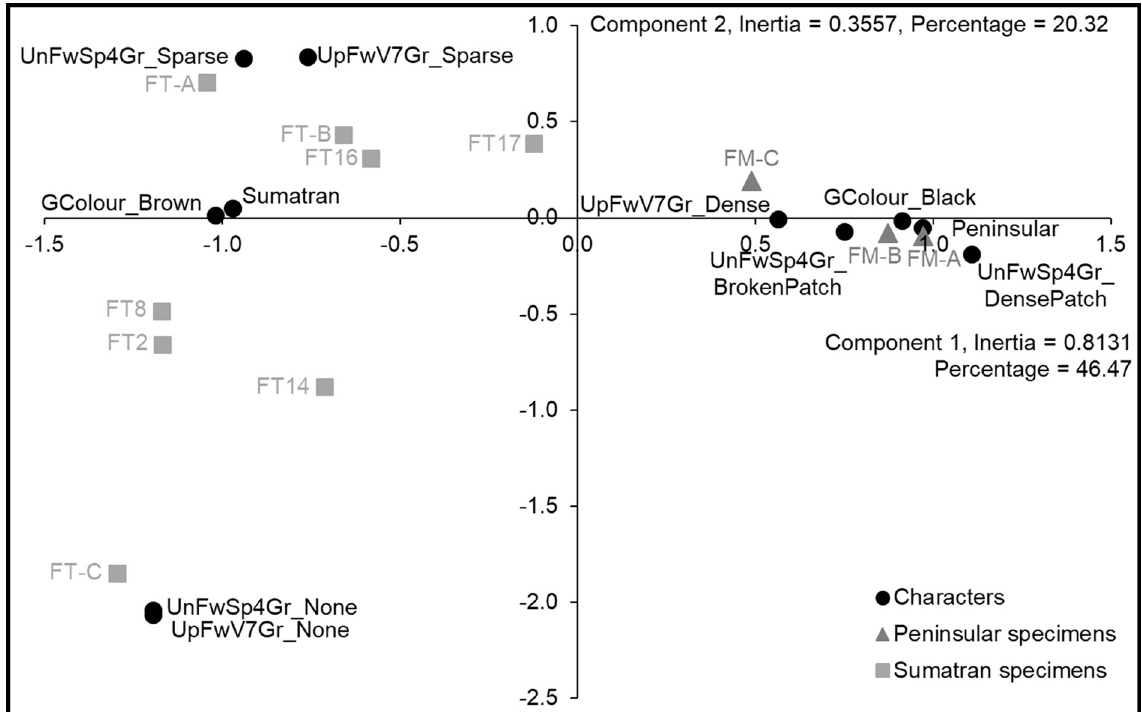
Fig. 5. Two-dimensional plot of correspondence analysis components 1 and 2 for females. Specimens with identical coordinates are grouped together (e.g., FT-A = female, Sumatra, group A; Fm-A = female, Peninsular malaysia, group